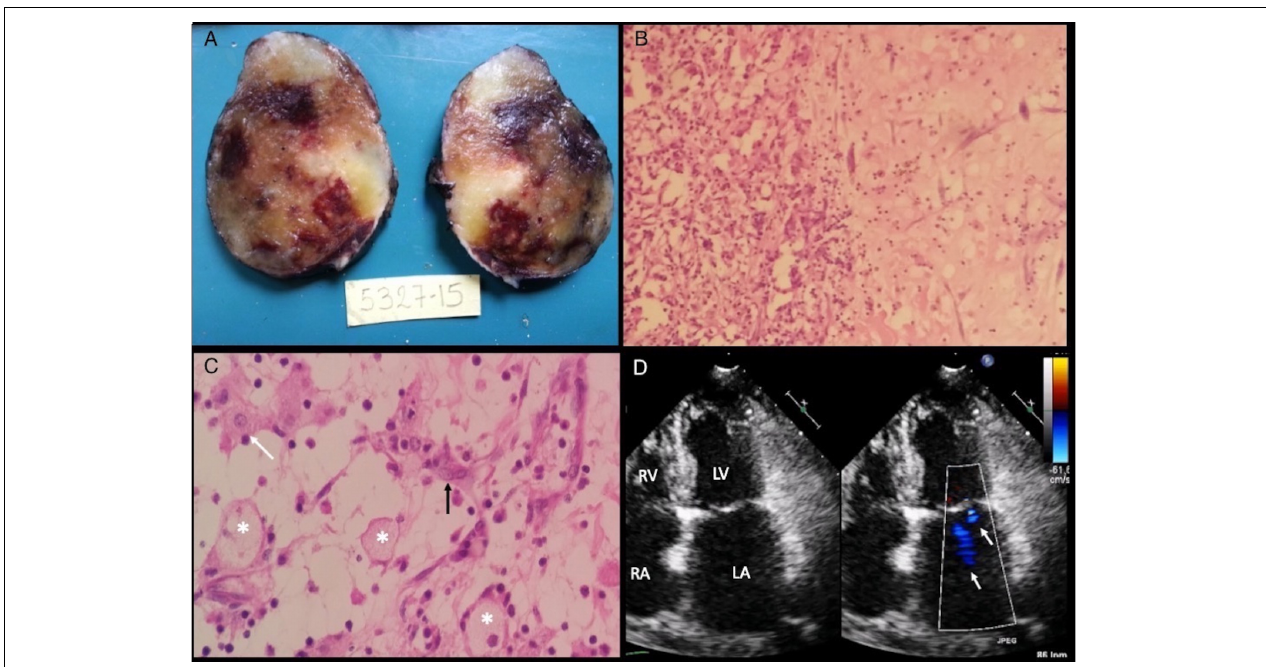
FIGURE 4 | Macroscopic and microscopic specimen findings. (A) Oval mass of 80 grams, 7 × 4 × 5 cm of diameter with a smooth surface showing white/yellow colors with zones of hemorrhagic aspect. Intact capsule that delimits the entire mass, compatible with its benign and non-invasive nature. (B) On the left side, a pattern of glanduloid/vascular cavities with abundant inflammatory lymphocytic infiltrate. On the right side, homogeneous stroma with clear spaces and isolated myxoma cells with fusi morphology. H/E10x (C) Myxoma’s stroma shows decreased cellular density and multiple blood vessels (asterisks). Stellate appearance cells present eosinophilic cytoplasm and round nucleus (white arrow). Syncytial Cells with a string morphology (black arrow). H/E 40x. (D) Follow-up echocardiogram. 2D and color flow TTE in four-chamber view with 2 jets of mild mitral regurgitation (white arrows) and no cardiac mass in the left atrium. Abbreviations as